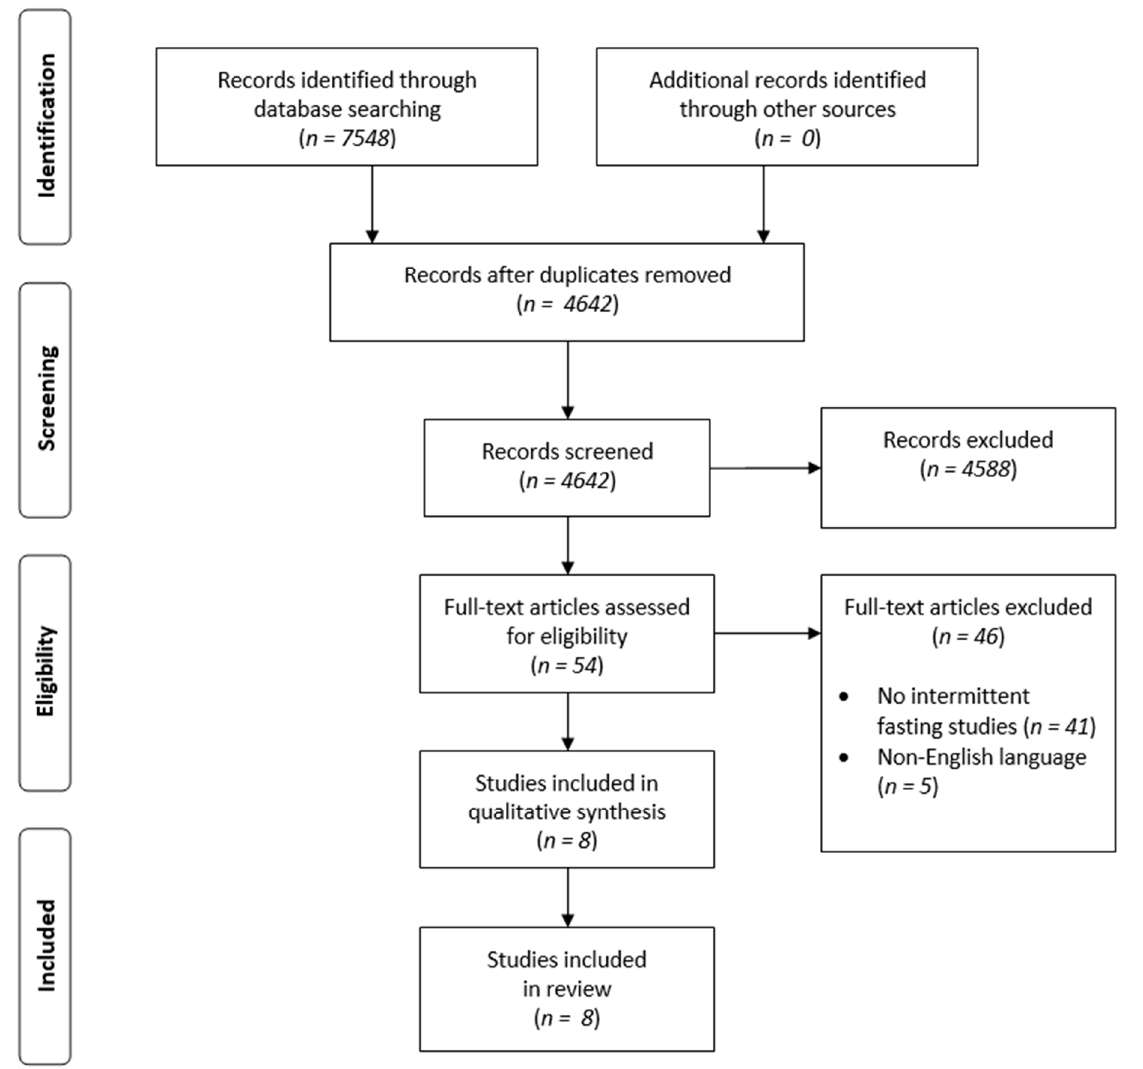
Figure 1. PRISMA flow diagram of the study selection.